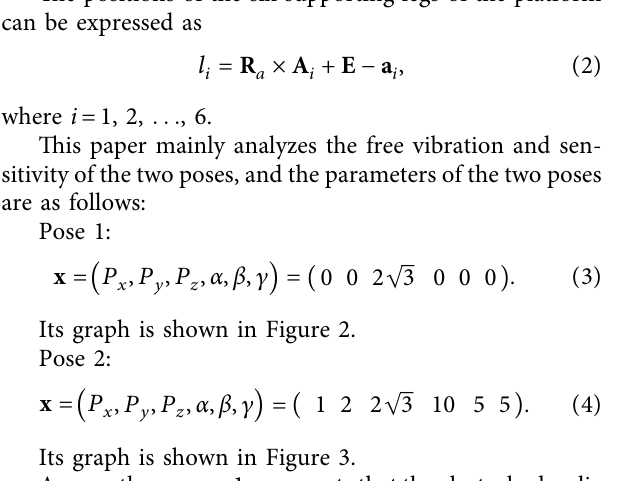
Figure 2: Schematic diagram of 6-DOF platform under pose 1.